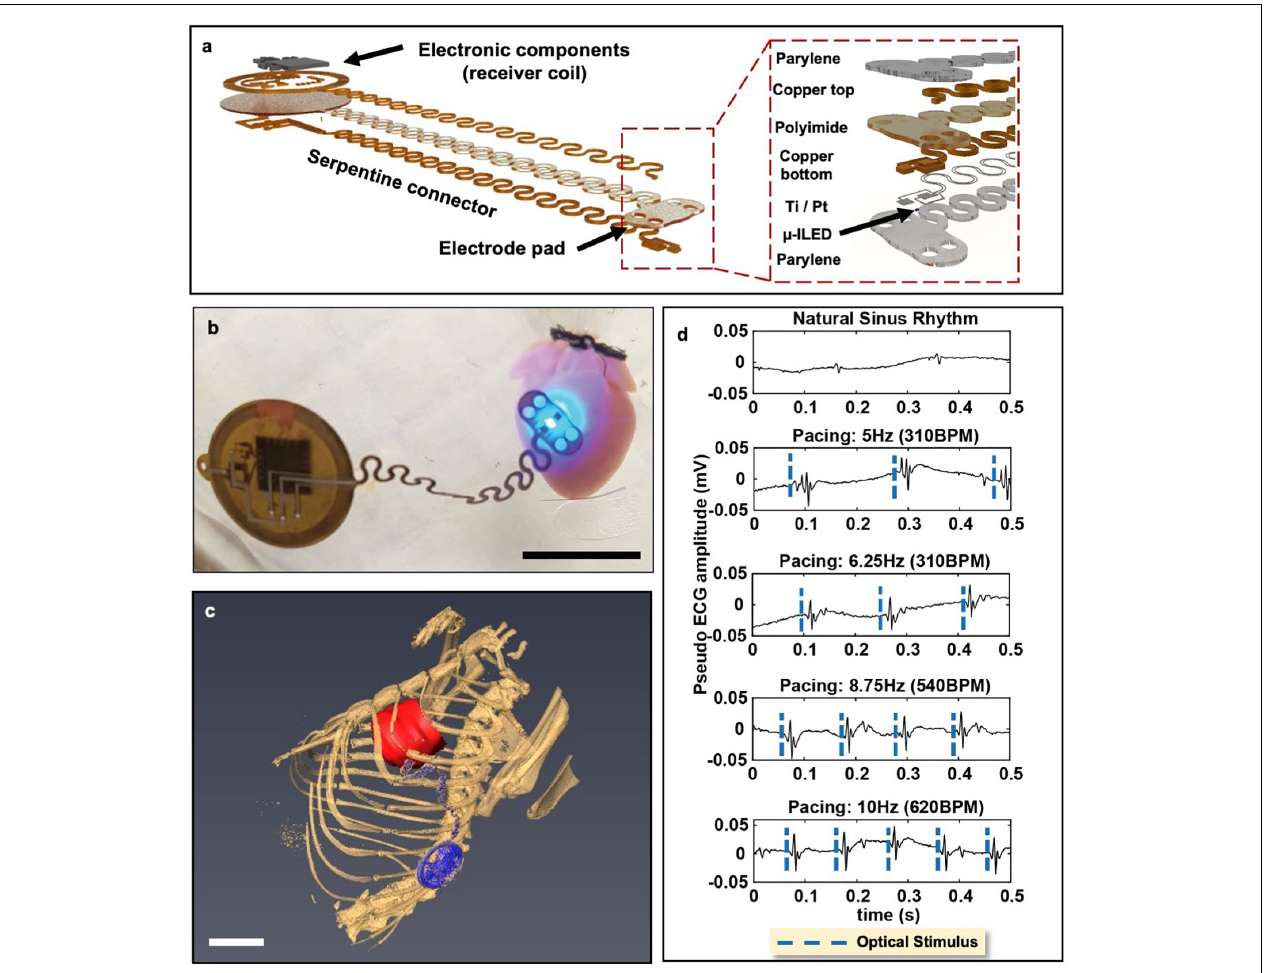
FIGURE 4 | Wireless, battery-free, full implantable optical pacemaker. (a) Rendered images of the layered composition of the miniature wireless optical pacemaker. The receiver coil receives energy to power the pacemaker. The electrode pad is placed onto the epicardium for pacing. (b) A representative image of the pacemaker performing optical pacing on a ChR2-expressing mouse heart. Scale bar, 1 cm. (c) 3D segmentation of anatomical positioning of the pacemaker (blue) with respect to the rat heart (red). Scale bar, 1 cm. (d) Ex vivo ChR2-expressing mouse hearts were paced at 280 BPM, 310 BPM, 540 BPM, and 600 BPM. Adapted from Gutruf et al.